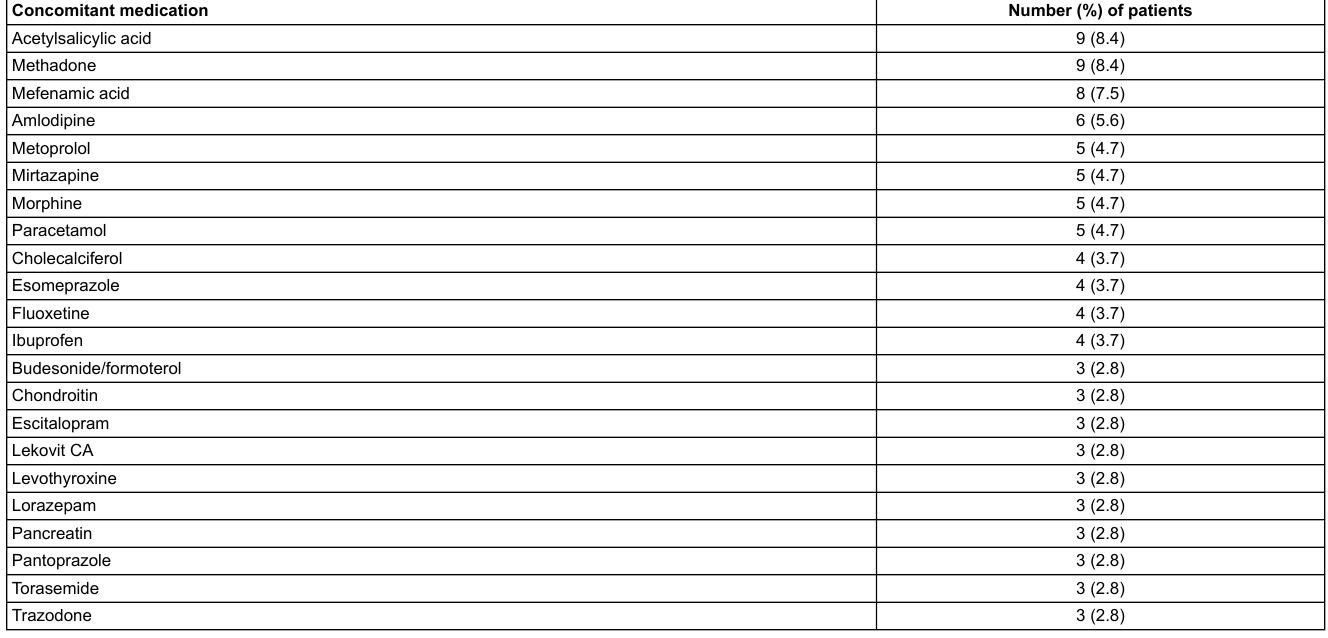
Table S6: Most frequently reported concomitant medications (≥2% of patients) (safety population, N = 107). Concomitant